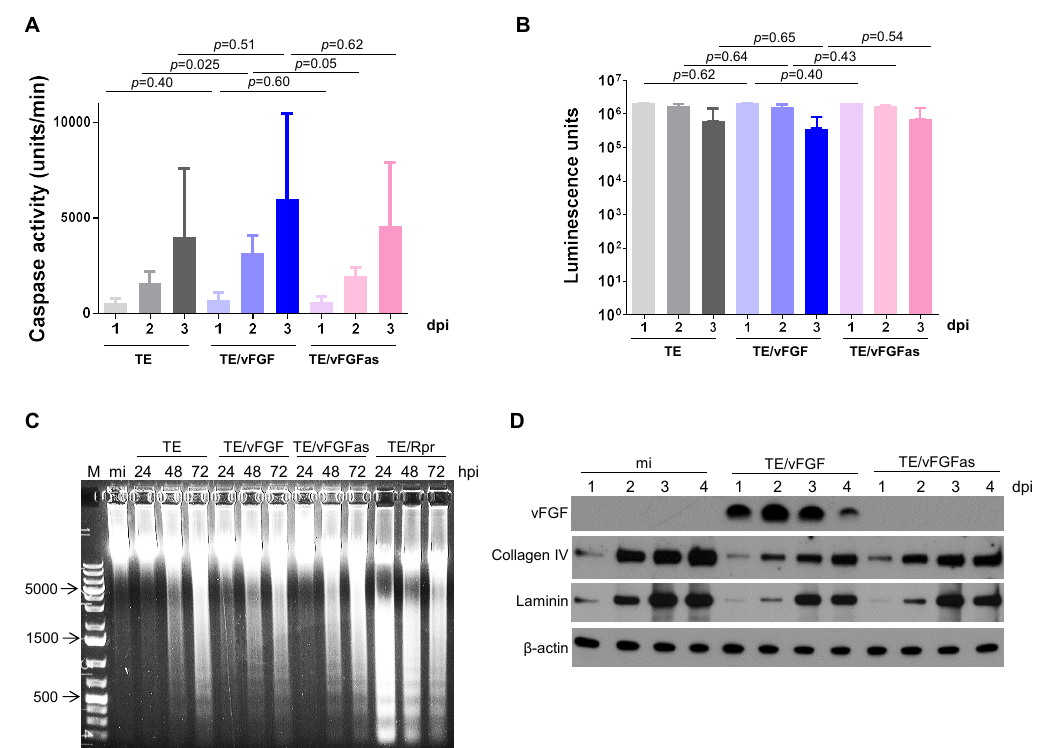
Figure 5. E ff ects of vFGF on caspase activation and cleavage of basal lamina proteins in SINV-infected cells. ( A ) Lysates from C6 / 36 cells infected with the indicated viruses were used to determine e ff ector caspase activity, as measured by the cleavage rate of a fluorogenic caspase substrate (Ac-DEVD-AFC). The bars indicate the means ± standard error from four independent experiments. Significance was determined by t test. ( B ). Cell viability assays using the CellTiter-Glo kit were performed with C6 / 36 cells infected with SINV. The bars indicate the means ± standard error of three independent experiments. Significance was determined by t test. ( C ) C6 / 36 cells were mock-infected (mi) or infected with the indicated viruses and total cellular DNA was extracted and analyzed by agarose gel electrophoresis and ethidium bromide staining. The numbers to the left indicate base pairs from the marker (M) lane. ( D ). The accumulation of the proteins indicated to the left was detected by immunoblotting from supernatants of C6 / 36 cells infected with the indicated viruses. The blot shown is representative of three independent experiments. β -actin was detected as a loading